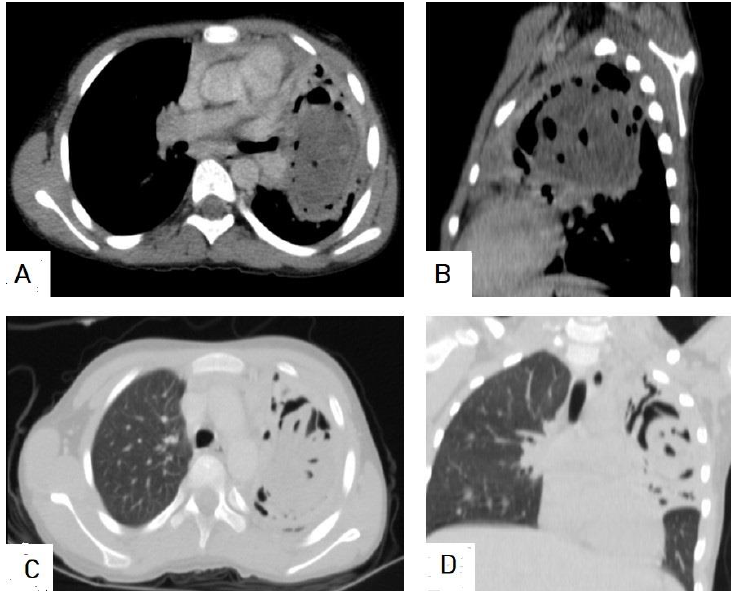
Figure 21. Selected sections of chest CT images of a 10-year-old female presenting with cough, dyspnea, and hemoptysis showing a hypodense lesion in the left lung with thick-enhancing wall seen on axial ( A ) and sagittal ( B ) mediastinal window sections. The “air-bubble” sign inside the lesion is seen in the mediastinal window sections ( A , B ), and on the lung window axial ( C ) and coronal ( D ) sections. Picture is in keeping with ruptured hydatid cyst.